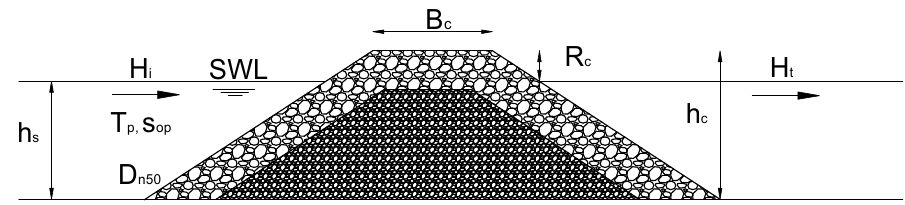
Figure 1. Definition sketch for wave transmission.